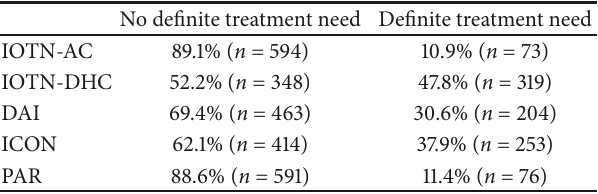
Table 1: Normative orthodontic treatment need assessed with the IOTN-AC, DAI, ICON, and